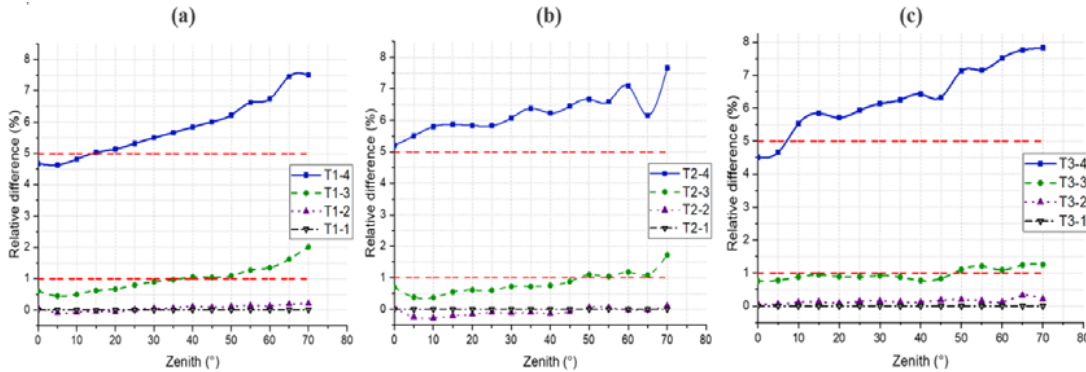
Figure 11. Relative difference of gap fraction (North direction), ( a ) first stage, ( b ) second stage, and ( c ) last stage. The dashed lines in red show the relative difference of 1% and 5%.